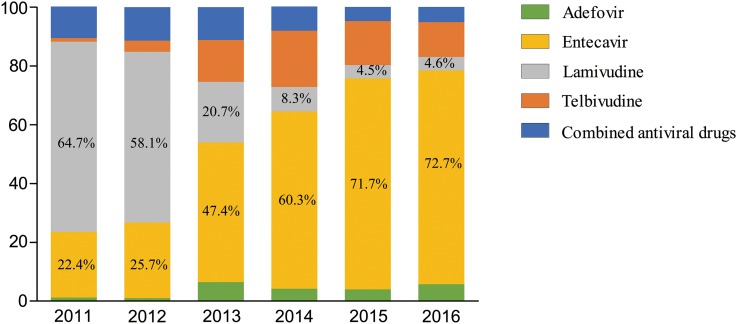
Percentage drug distribution in patients with nucleos(t)ide analogues from year 2011 to year 2016